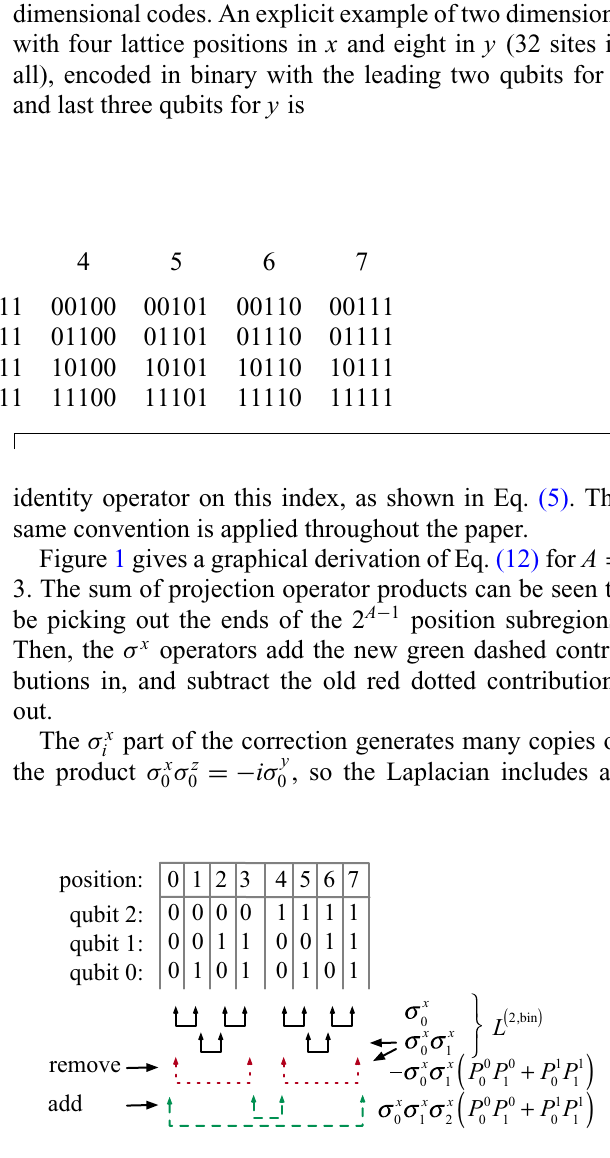
FIG. 1. The three-qubit binary encoded Laplacian is con- structed from the two-qubit Laplacian and two corrections. The columns under the position index line are the position encod- ing in qubit states. For example, position state 4 in the second subblock is encoded as 100 in qubit states specified below posi- tion index 4. The horseshoe shaped lines with arrows indicate the symmetric contributions between neighboring positions. The first three row of lines show the contributions inherited from L ( 2,bin ) , including contributions shown as red (dotted) lines that are excess in the A = 3 context. The excess contribution is (cid:18) (cid:19) σ x + P 1 . The green (dashed) removed by term − σ x P 0 P 1 P 0 0 1 0 1 0 1 lines indicate the two contributions not provided by L ( 2,bin ) that are added by the term to the right. The corrections are shown next to the red and green